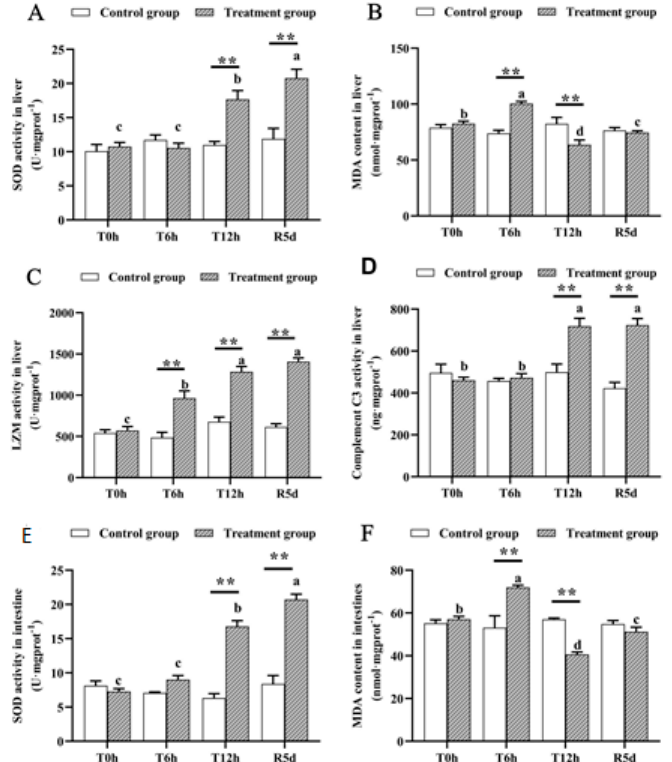
Figure 3. Antioxidant- and immune-related physiological parameters in the livers and intestines of juvenile largemouth bass under transport stress. Superoxide dismutase, SOD; malondialdehyde, MDA; lysozyme, LZM ( A ) liver SOD; ( B ) liver MDA; ( C ) liver LZM; ( D ) liver complement C3; ( E ) intestinal SOD; ( F ) intestinal MDA. T0h: transport stress at 0 h; T6h: transport stress at 6 h; T12h: transport stress at 12 h; R5d: recovery for 5 d. **: significant difference between the control and treatment groups (paired samples t ‐ test, **: p < 0.01). Lowercase letters indicate significant differences ( p < 0.05) between treatments (Duncan’s multiple ‐ range test).